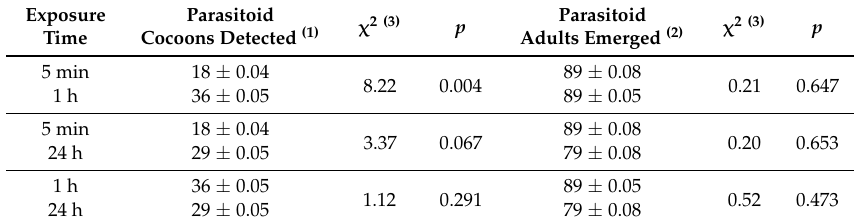
Figure 1. Effect of coccinellid species on parasitism by D. coccinellae . The coccinellids, H. axyridis ( n = 1348), C. septempunctata ( n = 113), A. bipunctata ( n = 43) and H. variegata ( n = 40) were field-collected from March to November in the year 2010 in the Bologna area (Emilia Romagna region, northern Italy). Columns indicate the percentage (±SE) of successfully parasitized coccinellids (i.e., coccinellid specimens from which a D. coccinellae cocoon emerged). See text for statistics. Table 1. Effect of exposure time of H. axyridis to D. coccinellae on mean (±SE) percentage of parasitoid cocoons detected and of parasitoid adults emerged from cocoons.